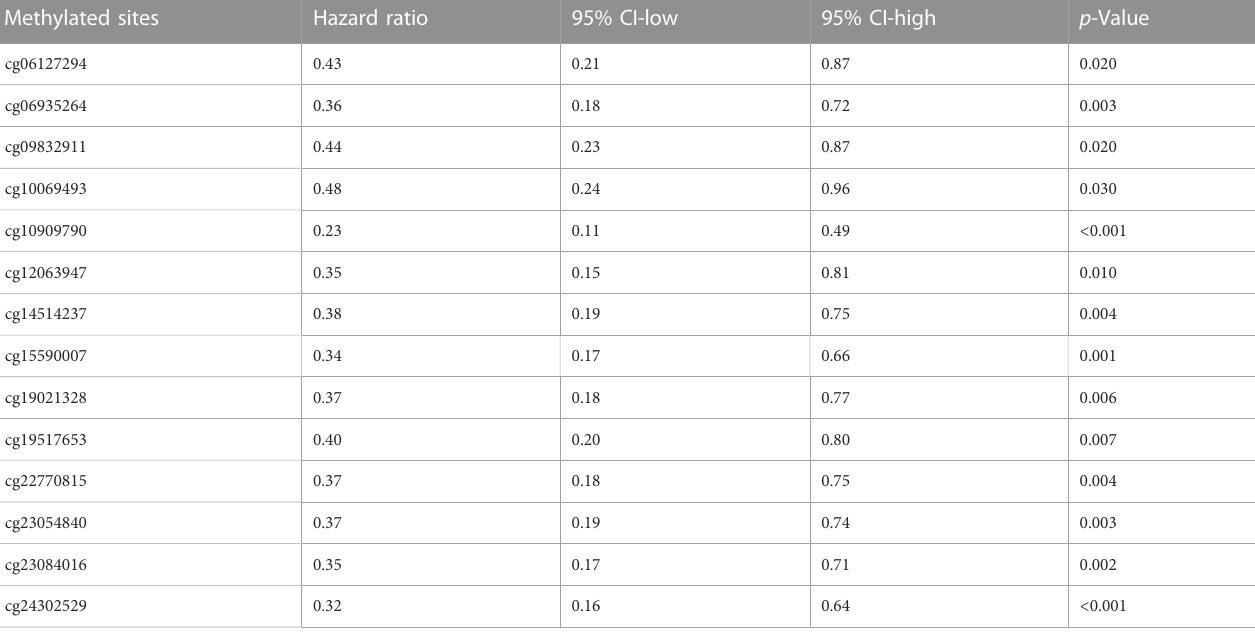
TABLE 6 Summary of the Kaplan-Meier curve data for the 14 methylated sites of ALOX5 in the TCGA-LGG dataset. Methylated sites Hazard ratio 95% CI-low 95% CI-high p